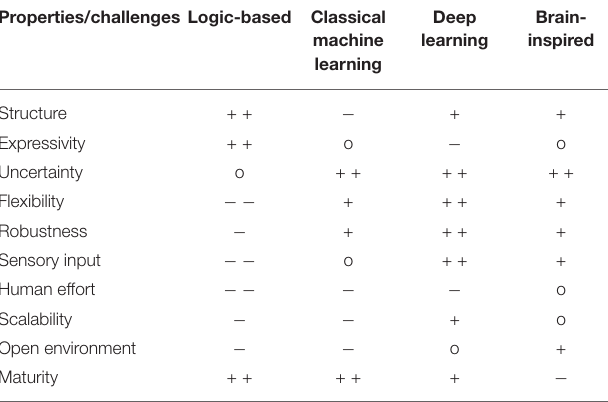
TABLE 2 | Summary comparison among the types of approaches in terms of their ability to represent structured data, their expressivity, their capacity to deal with uncertainty, their flexibility to adapt to different data, their robustness, their competency at handling sensor data, the human effort required to develop the system, their scalability, their aptness to deal with open environments, and the maturity of the technology. Deep Brain- Properties/challenges Logic-based Classical learning machine learning